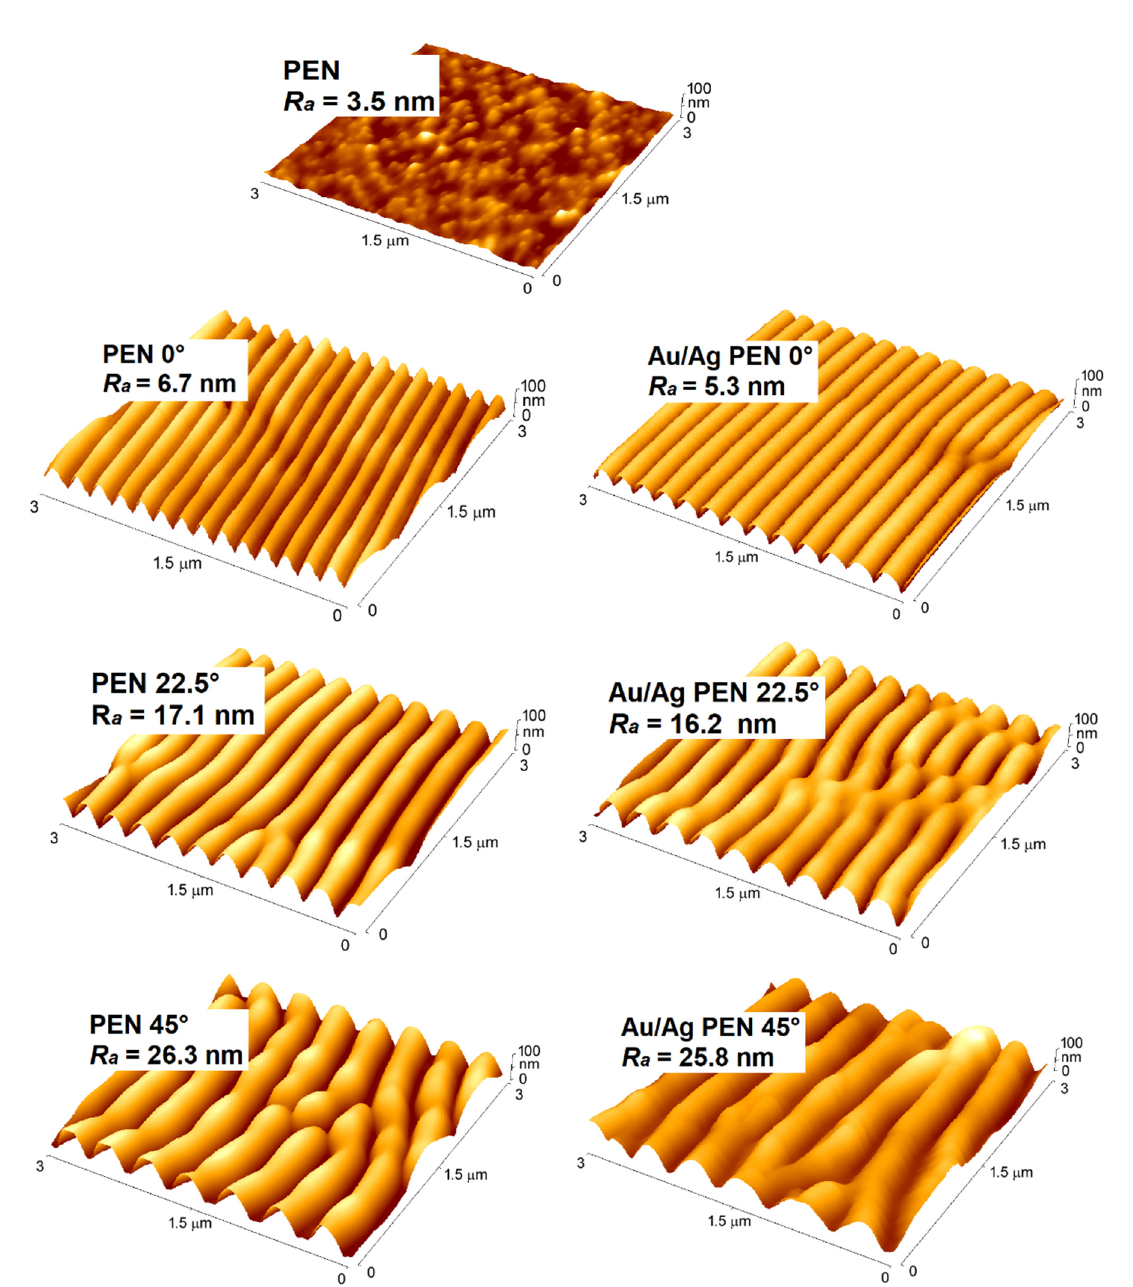
Figure 1. AFM 3D scans of PEN, PEN 0/22.5/45° and Au/Ag PEN 0/22.5/45° samples with corresponding values of surface roughness ( R a ). Table 1. Measured values of surface roughness ( R a ), periodicity ( Λ ) and height ( h ) of